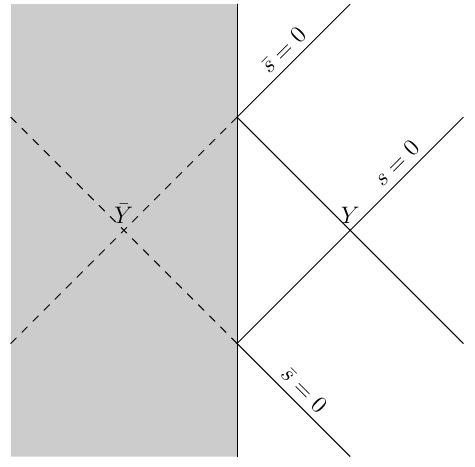
Figure 2 . Light cones in the case of the ideal